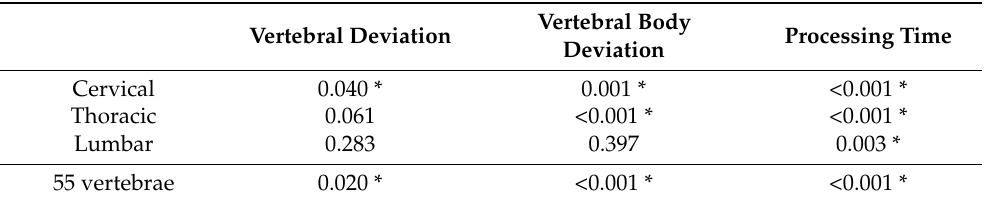
Table 3. Wilcoxon signed-rank test results of pairwise comparisons between the ICP and OSP-based contouring methods.